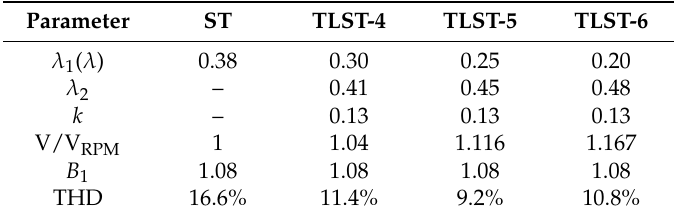
Table 2. Volume comparison at the same B 1 .